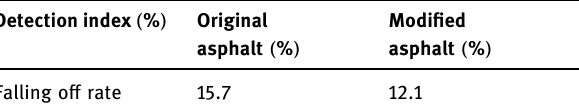
Table 4: Adhesion test results of two kinds of asphalt